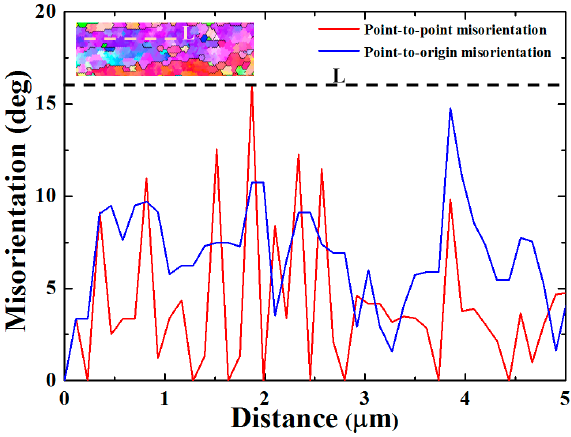
Figure 3. Misorientation profile along the dashed line taken from the rectangle A in the DSR-deformed 6061 Al alloy (Figure 2a).